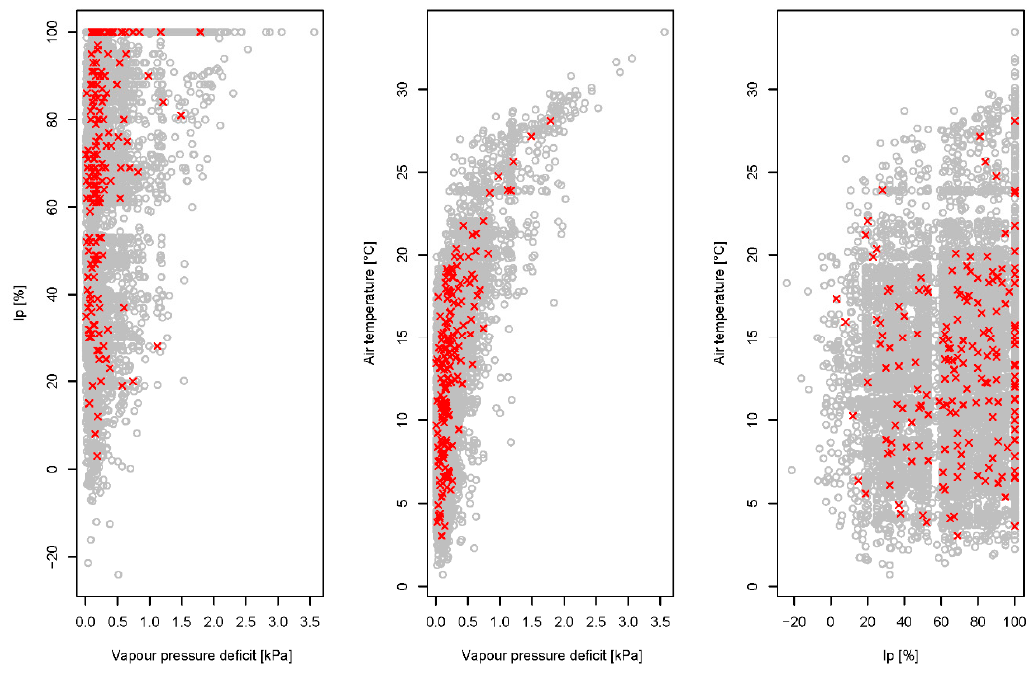
Figure 5. Graphical fit for pine trees between measured data (red crosses) and 10,000 random realizations (grey circles) using the copula model where the Joe copula was selected as C 1 and the Gumbel-Hougaard copula was selected as C 2 .